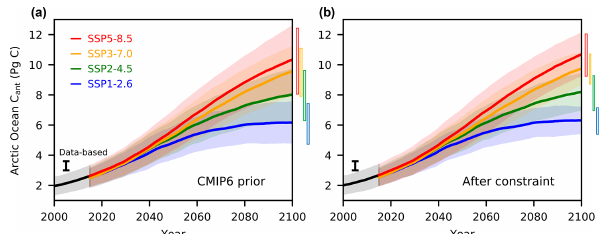
Figure 1. Arctic Ocean C ant inventory over the 21st century. (a) Time series of multi-model mean Arctic Ocean C ant inventory over the 21st century for SSP1-2.6 (blue), SSP2-4.5 (green), SSP3-7.0 (orange), and SSP5-8.5 (red) with the respective standard deviation across the model ensemble (shading) ( n = 12–14). The bars on the right side of panels indicate the inter-model standard deviation in the year 2100. (b) Time series of Arctic Ocean C ant inventory for each scenario after the emergent constraint is